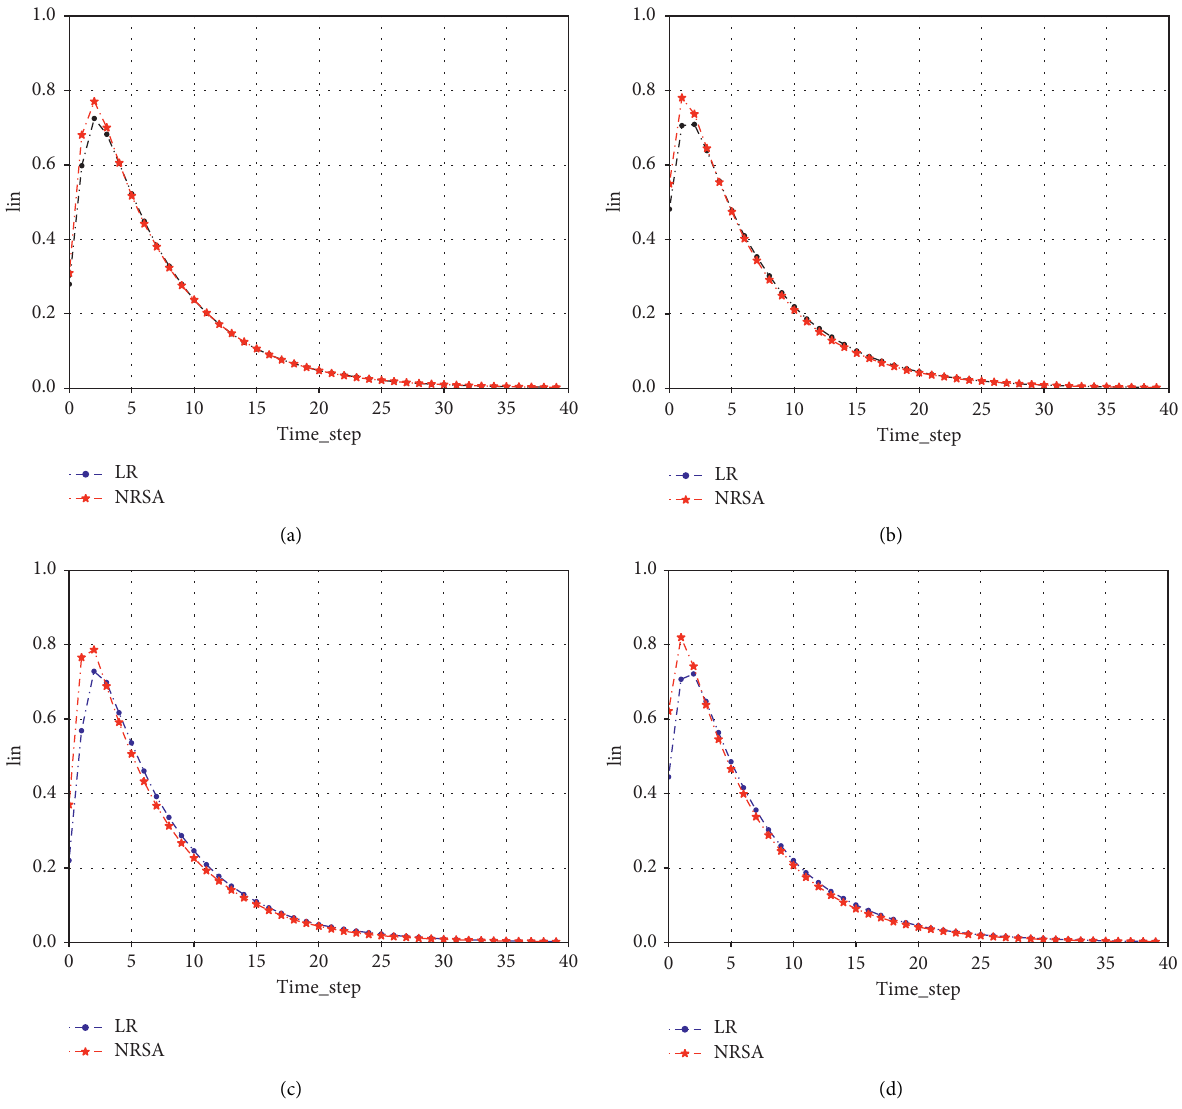
Figure 5: Comparison of neural network propagation results. (a) Top 10% comparison, (b) top 20% comparison, (c) top 10% comparison, and (d) top 20%